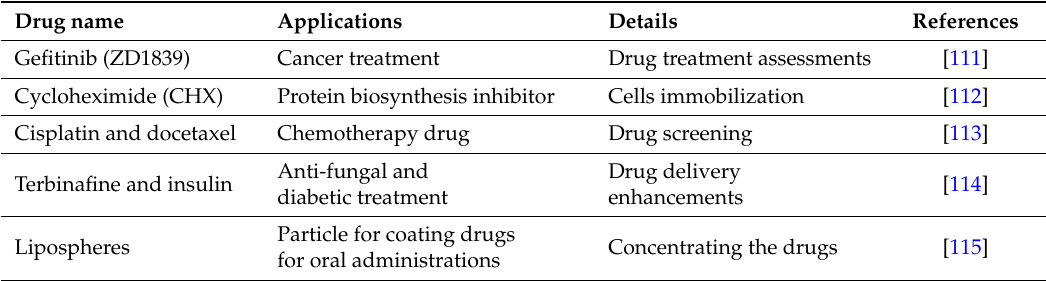
Table 5. DEP investigations in drug delivery